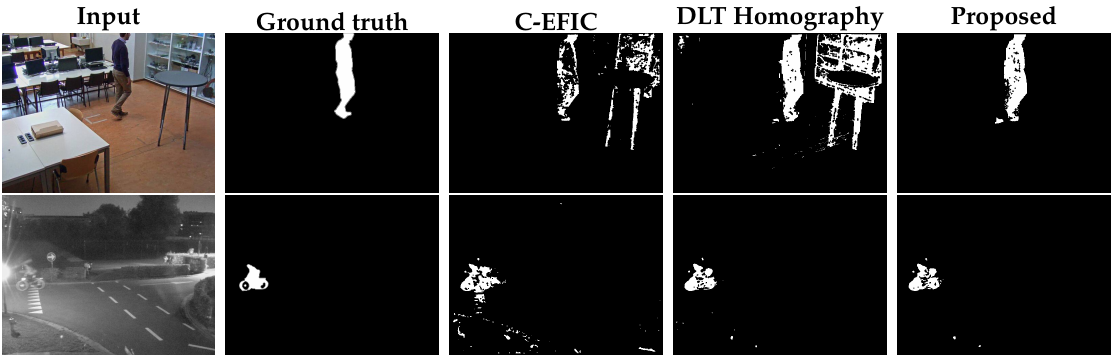
Figure 9. Foreground–background segmentation result for two handpicked fixed tilt panning frames, using 12 feature points per frame. Top row: indoor sequence, bottom row: outdoor night sequence